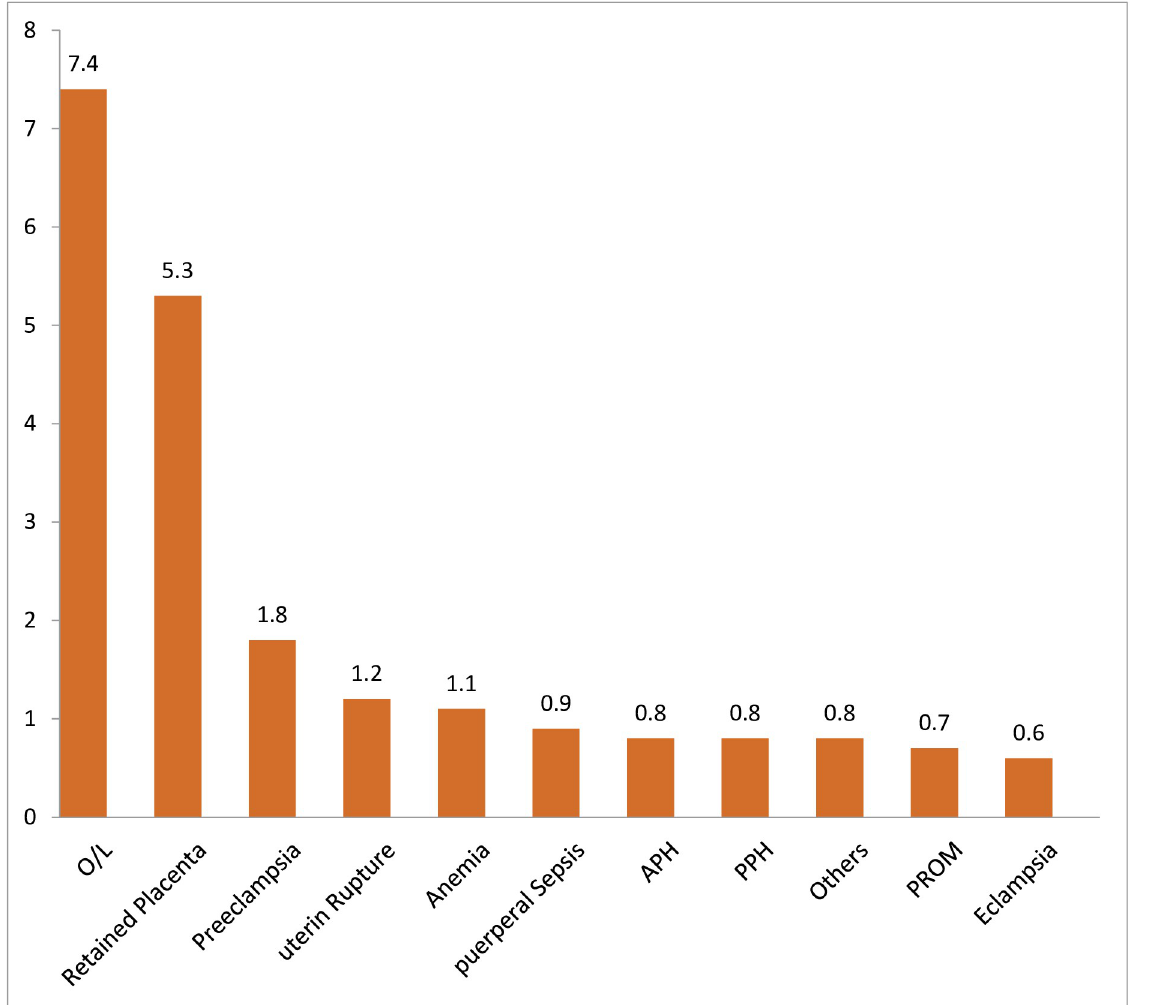
Fig 1. Obstetric complications at Debre Berhan Comprehensive Specialized Hospital, Northeast